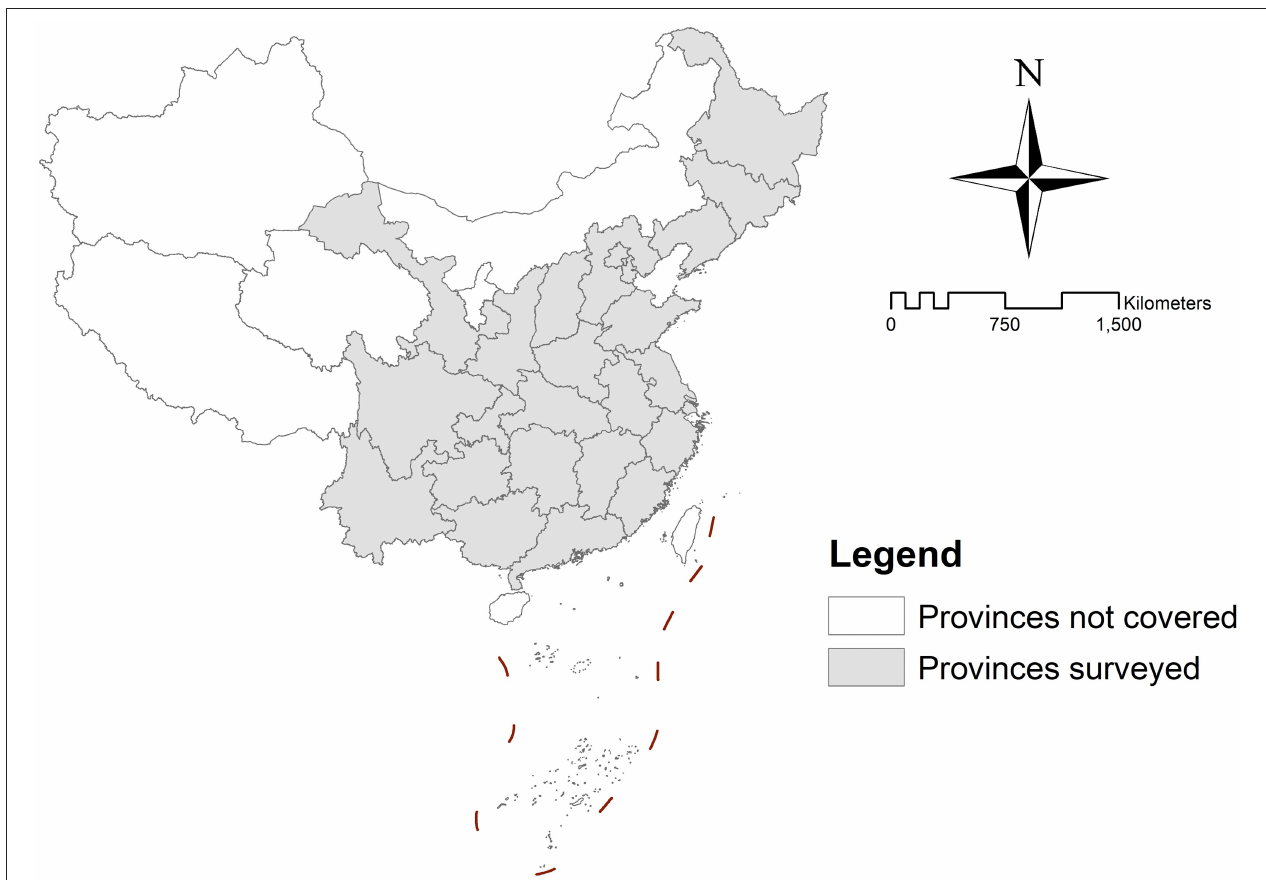
FIGURE 2 | Provinces covered by the CFPS 2016